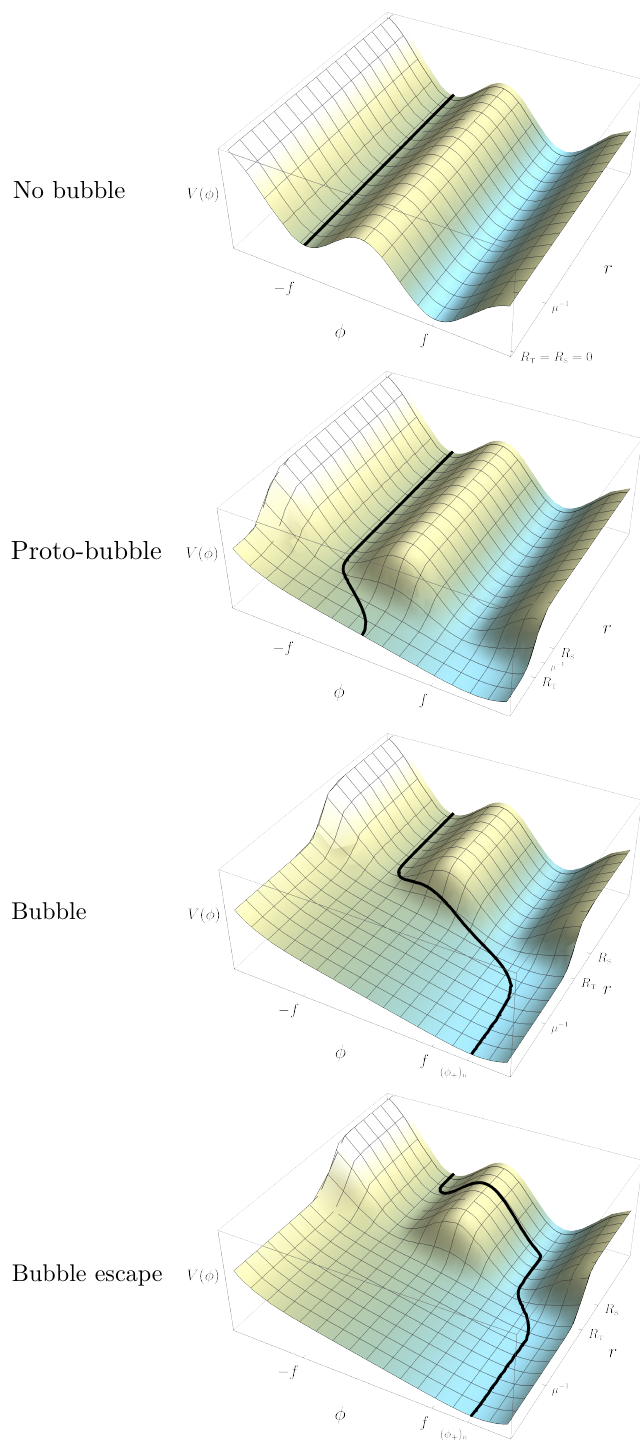
Figure 2: Quasi-static evolution of the in-density potential and scalar field profile, from no star to, as the star grows, the formation of the proto-bubble, complete for- mation of the bubble, and eventual bubble